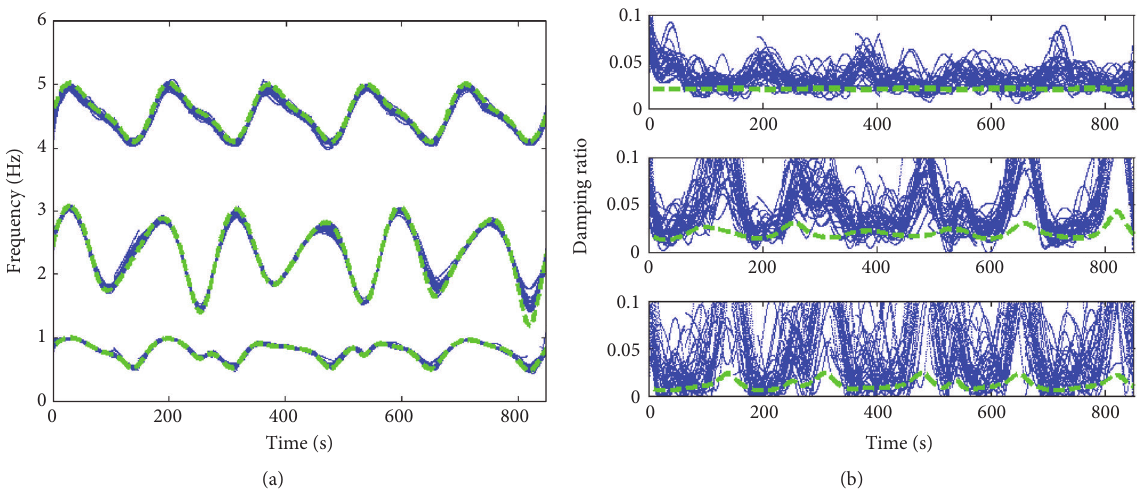
Figure 7: KRR-FS-TARMA based modal parameter Monte Carlo estimates (30 realizations): (a) natural frequency estimates and (b) damping ratio estimates.